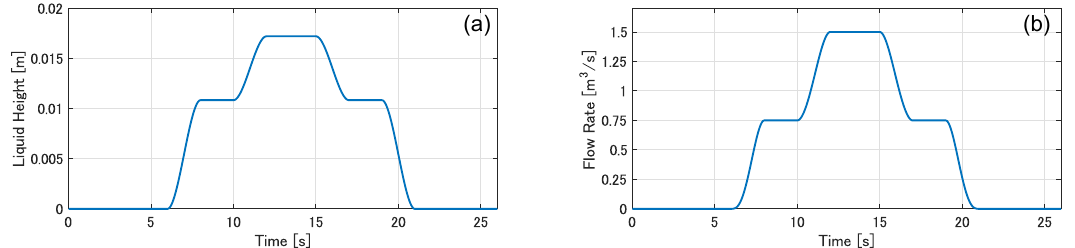
Figure 9. Reference trajectories in flow rate control. ( a ) Reference trajectory of liquid height at pouring mouth, which is added to the flow rate control. ( b ) Trajectory of flow rate, which is derived by substituting the reference trajectory of liquid height, presented in ( a ), into Equation